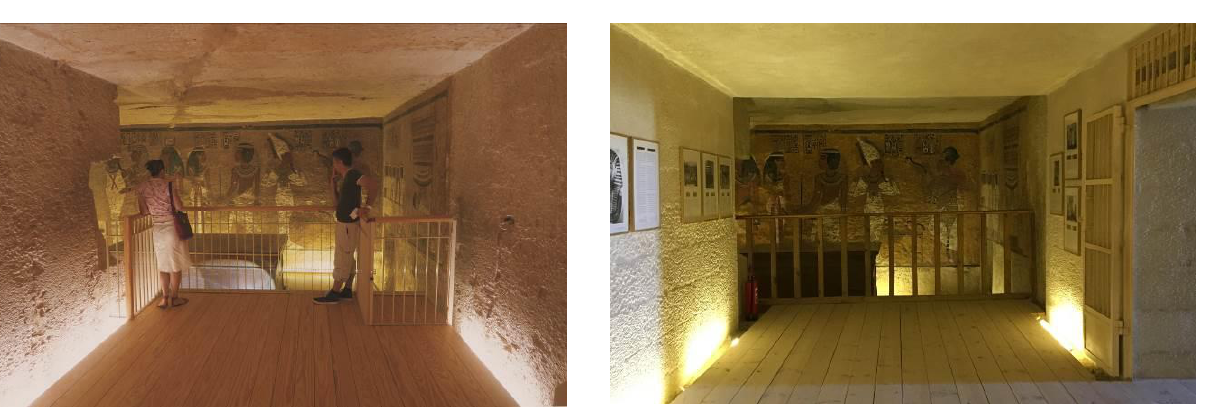
Figure 7. View of the antechamber looking north to the burial chamber © J. Paul Getty Trust 2015